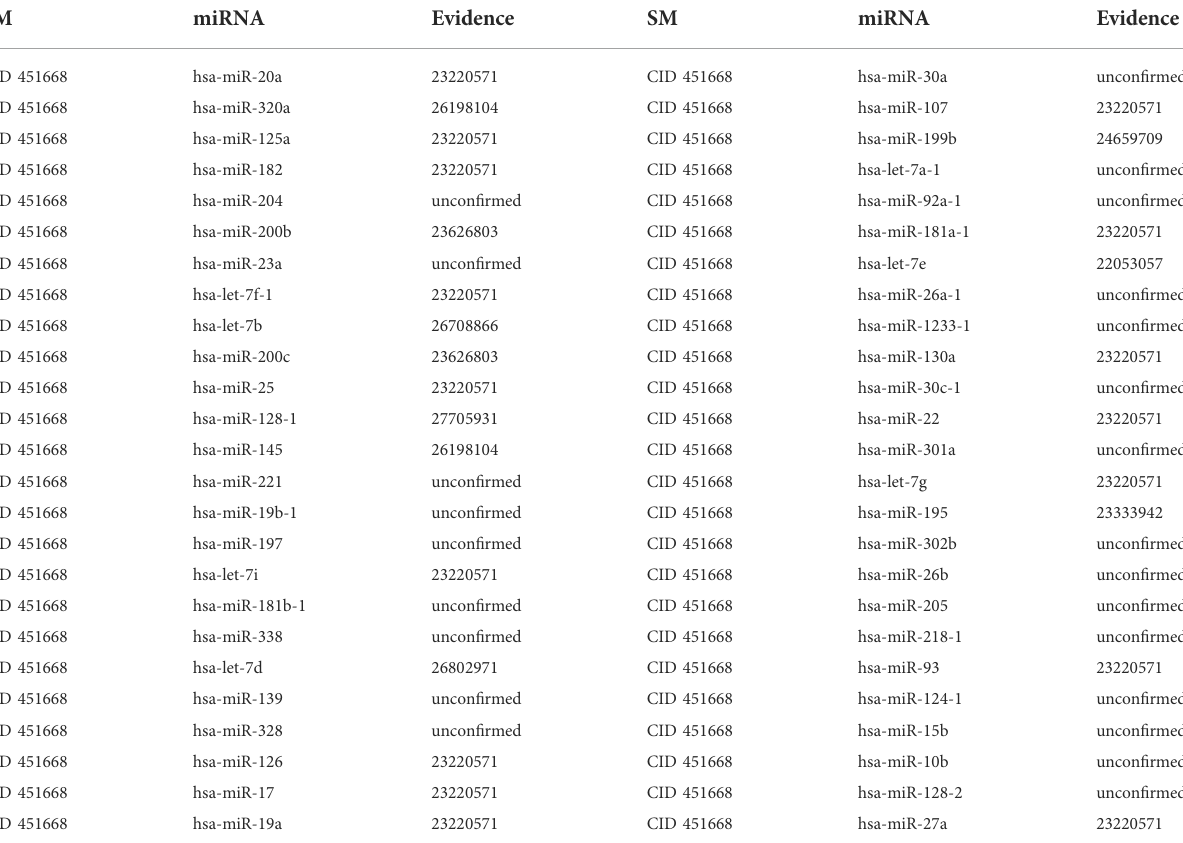
TABLE 5 Validation of the top 50 miRNAs associated with 5-Aza-CdR in the fi rst type of case studies. The fi rst column records the top 1 – 25 related miRNAs. The second column records the top 26 – 50 related miRNAs. SM